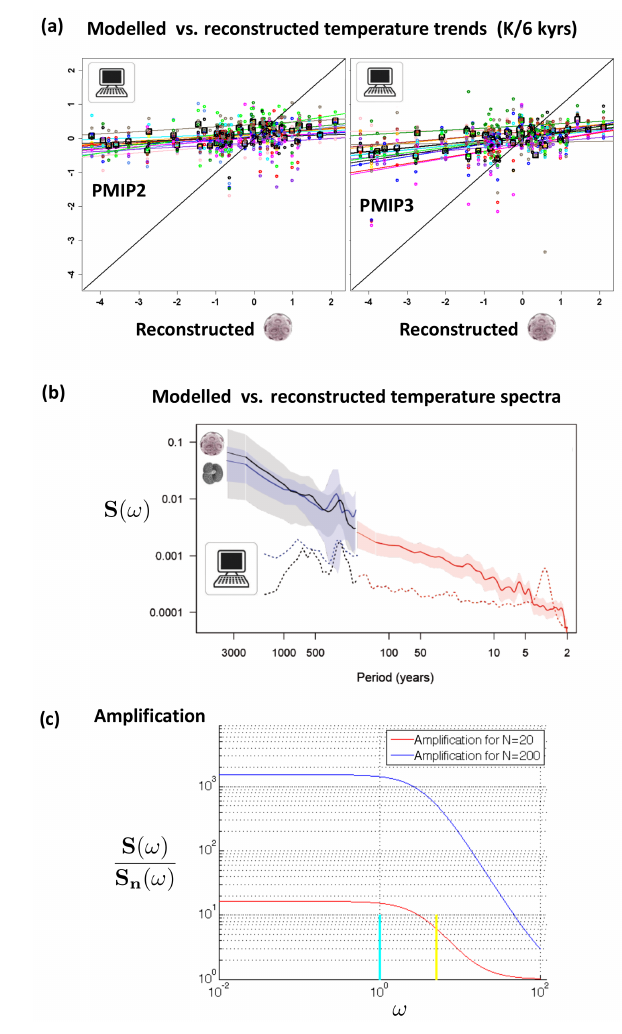
Figure 1. (a) Global alkenone-based SST trends compared to sim- ulated annual mean SST anomalies in the models listed in PMIP 2 and PMIP 3. The black squares represent the ensemble median mean and the colors correspond to a specific model (see Lohmann et al., 2013). Units are kelvin per 6kyr. (b) Spectrum of long-term multi-millennial climate model runs and instrumental and paleocli- mate data (courtesy of Thomas Laepple, modified from Laepple and Huybers, 2014b). Inherent uncertainties of the paleo-observations are accounted for (compare for instance the blue and black solid lines). (c) Amplification of the spectrum S ( ω ) /S n ( ω ) of the non- normal two-dimensional dynamics. The amplification can be sev- eral orders of magnitude depending on the degree of non-normality related here as the parameter N in Eq.